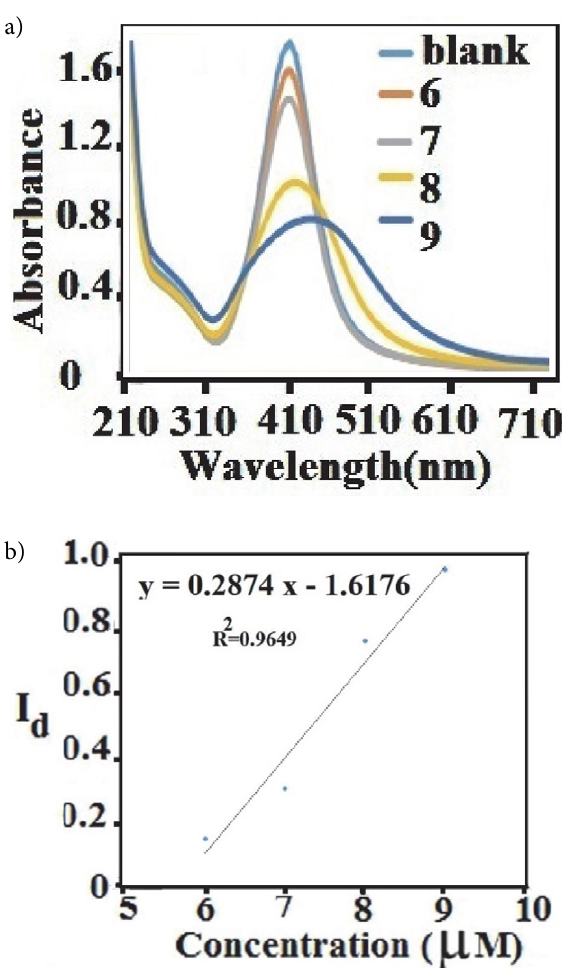
Figure 7. (a) absorption spectral changes observed for SDS-AgNPs after addition of Mn 2+ ions at a concentration range from 6.0 µM to 9.0 µM and plot of changes in the value of the absorption intensity at the maximum wavelength (λ410) of SDS-AgNPs against Mn 2+ ion concentration from 6.0 µM to 9.0